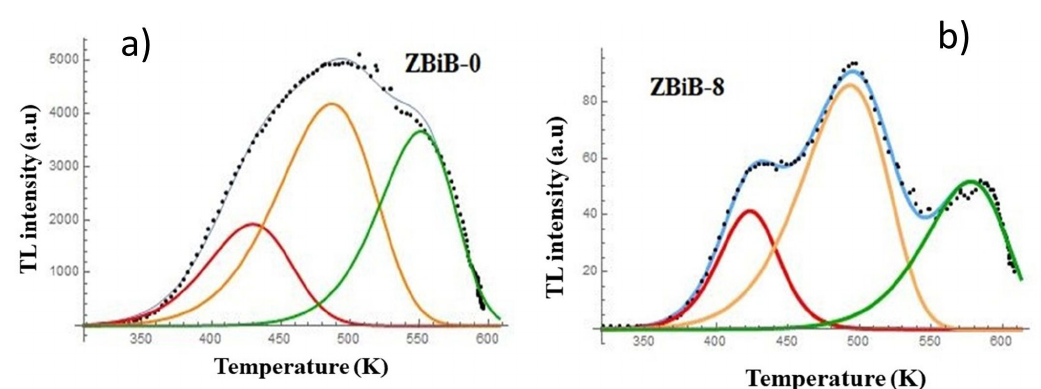
Figure 10. The deconvoluted glow curves of 5 kGy irradiated ZBiB-0 and ZBiB- 8 glasses obtained using CGCD technique.